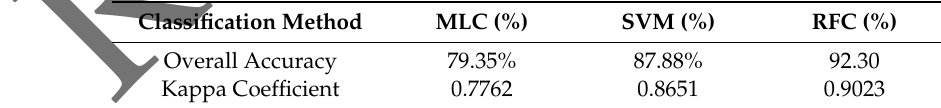
Table 8. Comparison of different methods.